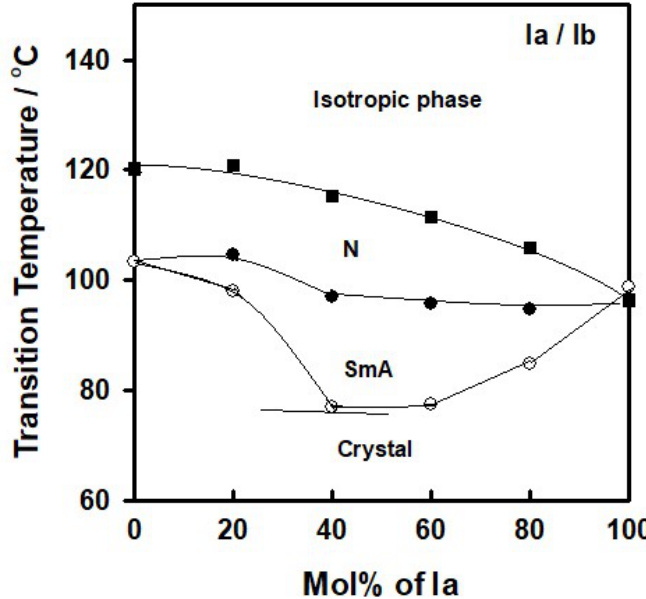
Figure 3. Binary phase diagrams for system Ia / Ib; the symbol “o” denotes the solid–SmA phase, “ • ” the SmA–N phase transitions, “ ■ ” N–I phase transition upon second heating, and “------” denotes to eutectic mixture.